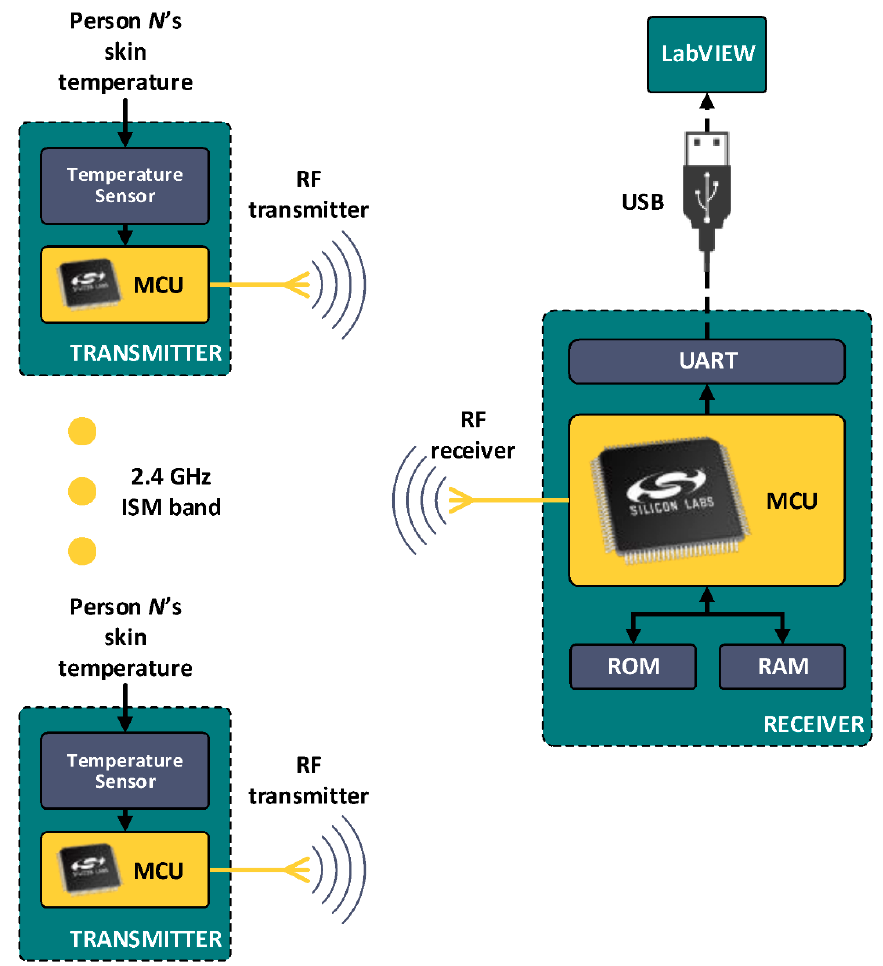
Figure 9. Block diagram of the Wei et al. wireless health monitoring system (modified from [145]).